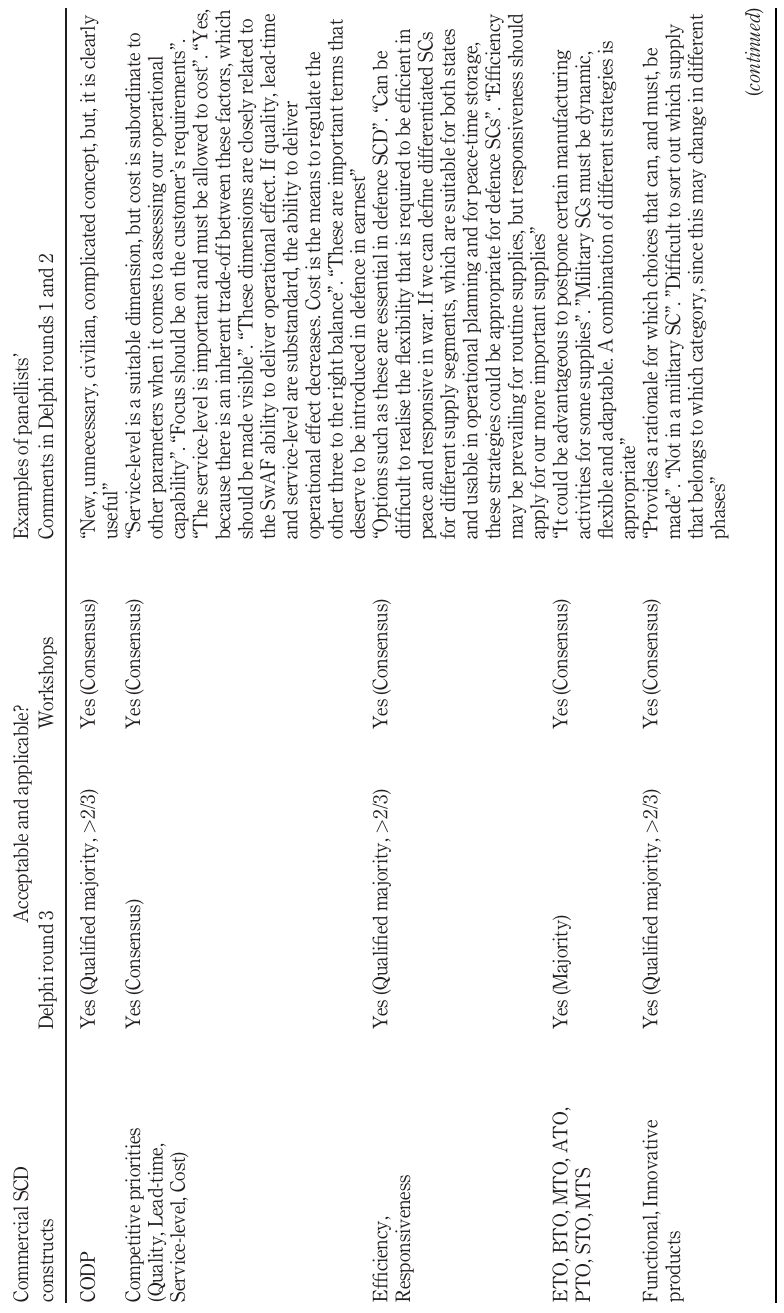
Table 4. Results from the Delphi